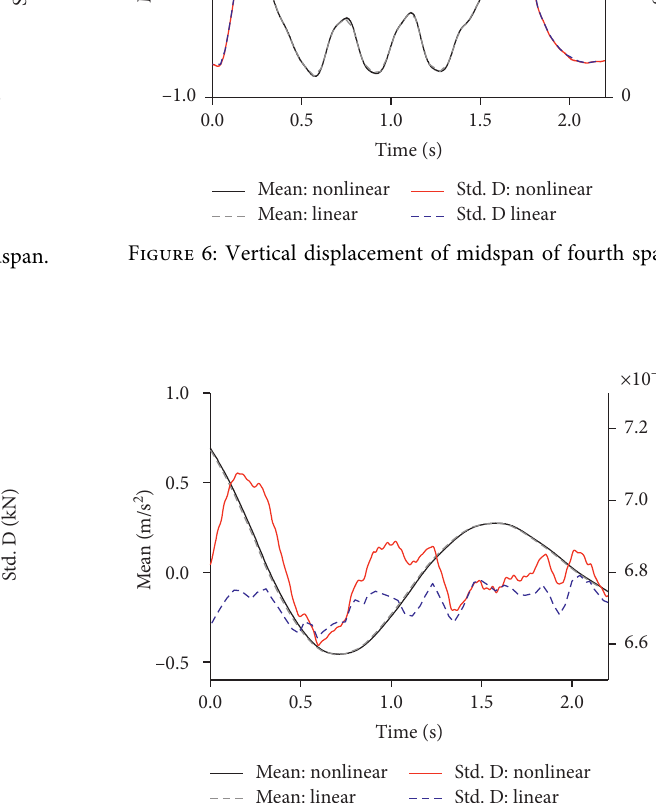
Figure 7: Vertical acceleration at the center of gravity of first